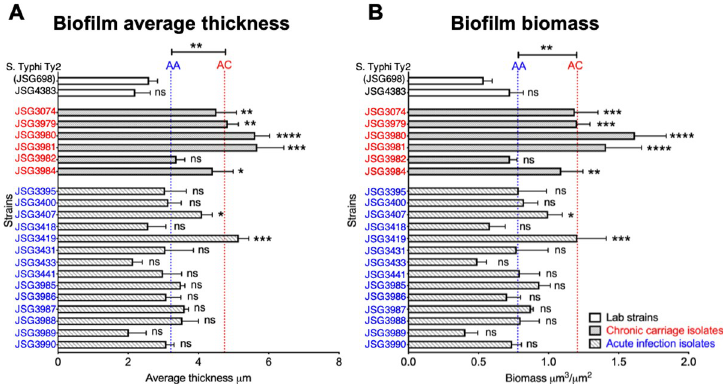
Fig 2. Chronic carriage isolates formed thicker biofilms than acute isolates. Biofilms of each of the indicated S . Typhi strains were established in a 8-well chambered coverglass slide for 40 hours. Biofilms were stained with LIVE/ DEAD stain and visualized via CLSM. Images were analyzed by COMSTAT to calculate average thickness ( A ) and biomass ( B ). Bars represent the standard error of the mean (SEM). The mean of the average thickness or biomass of the chronic carriage isolates was represented by the red dotted line labeled AC and the mean of the average thickness or biomass of the acute isolates was represented by the blue dotted line labeled AA. Statistical significance of average